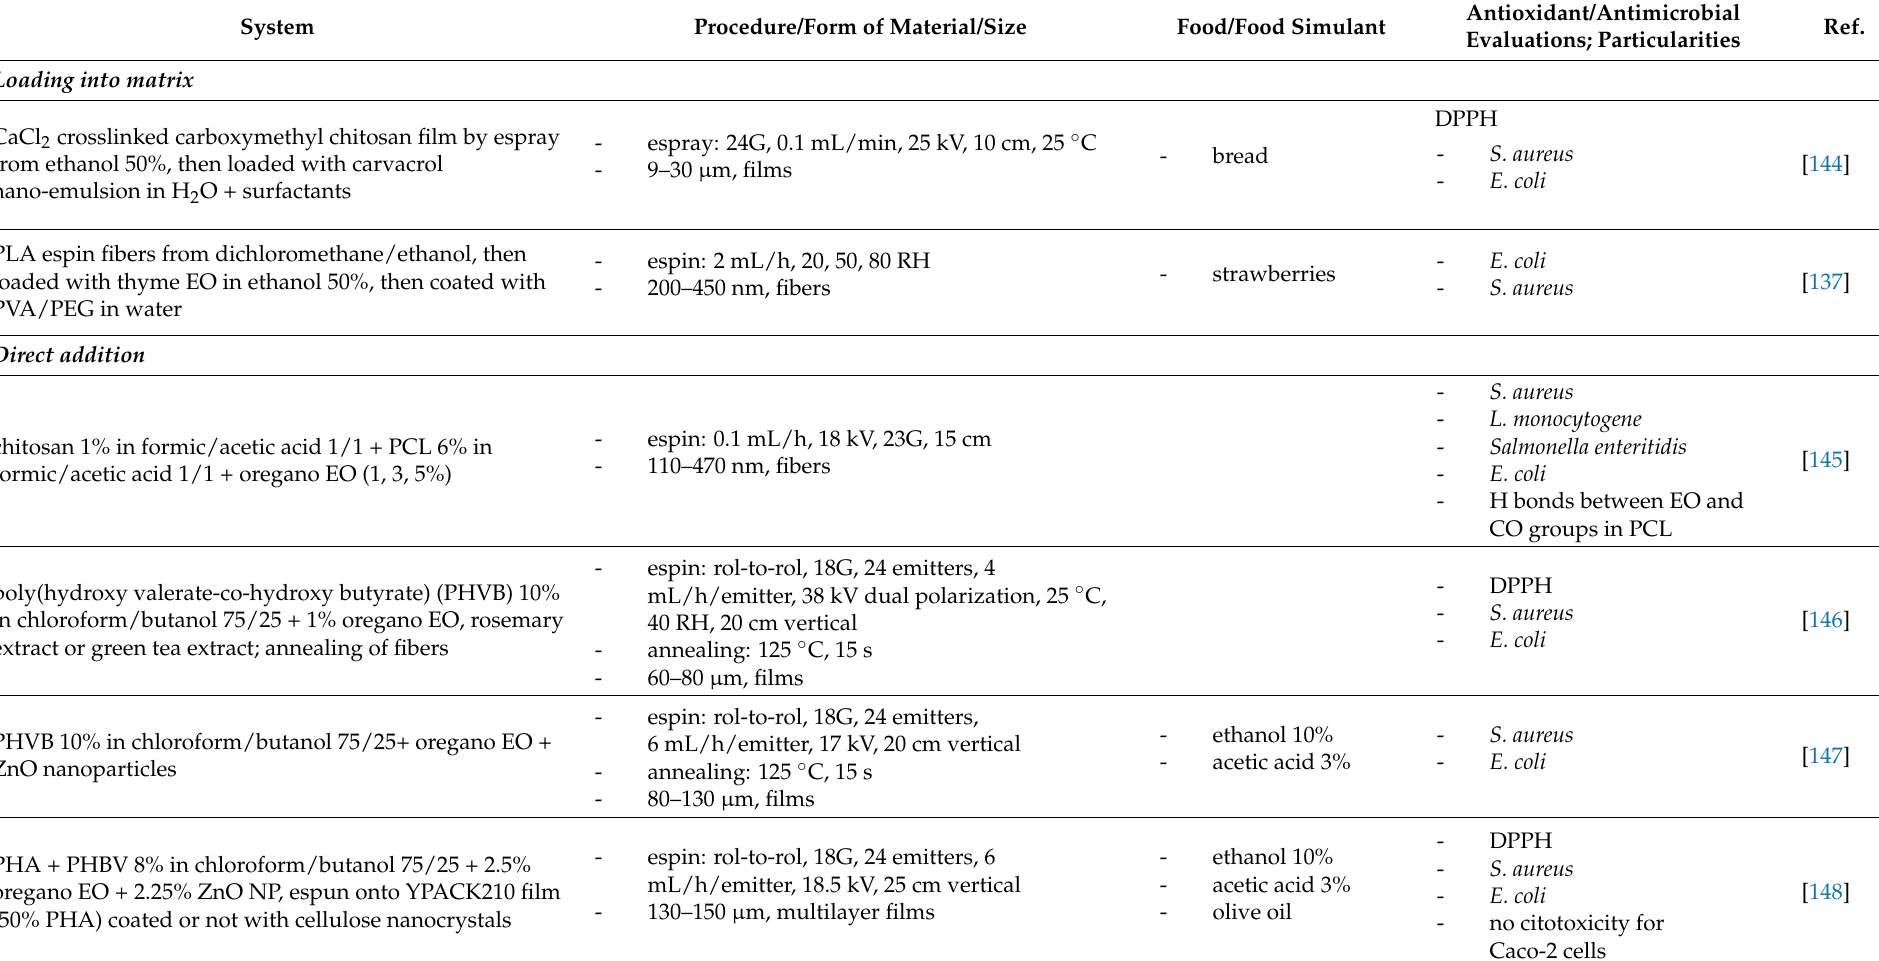
Table 2. Recent examples of essential oils or vegetal oils incorporated by electrospinning (espin)/electrospraying (espray) into polymeric materials for food packaging. System Procedure/Form of Material/Size Food/Food Simulant